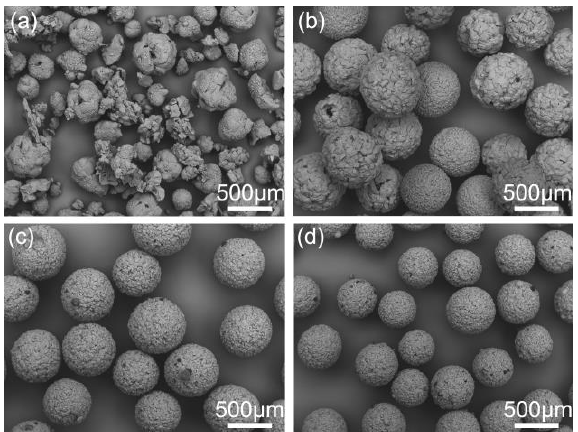
Figure 13. SEM images of the spherical crystals prepared at different concentrations of the emulsifier: